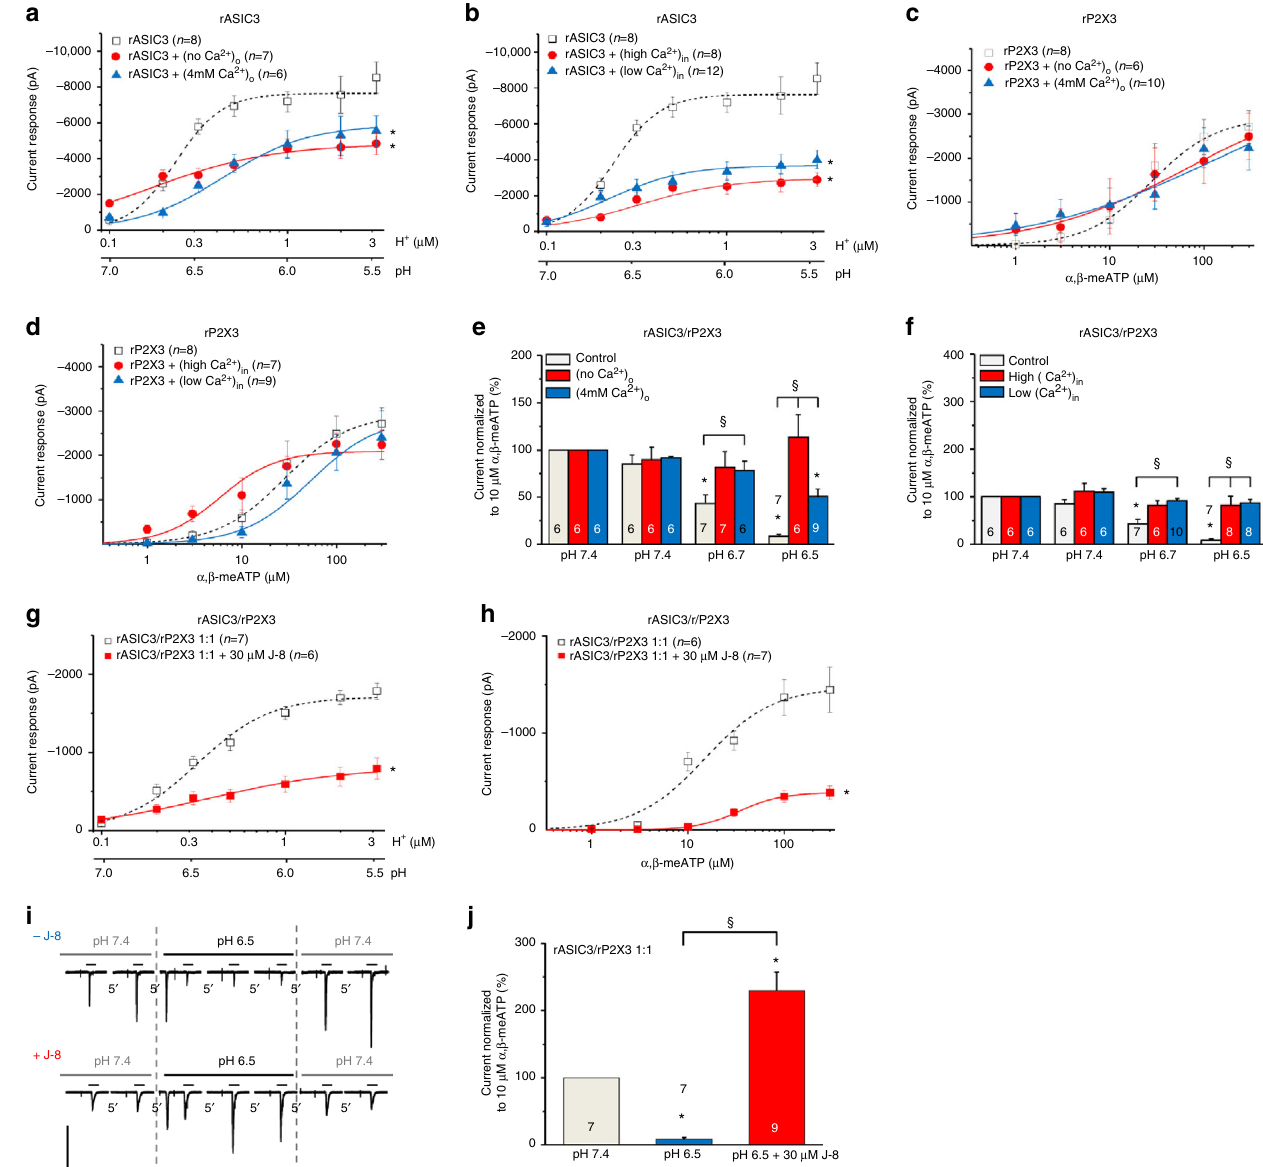
Fig. 4 Changes in the Ca 2 + concentration modify rASIC3 and rP2X3R currents in CHO cells. Whole-cell patch-clamp recordings at a holding potential of − 65 mV. a , b Concentration – response curves for protons in CHO cells transfected with rASIC3. a Inhibitory effect of an increase or decrease of the Ca 2 + concentration in the external medium ([Ca 2 + ] o ). b Inhibitory effect of an increase or decrease of the free Ca 2 + concentration in the patch pipette solution ([Ca 2 + ] i ). c , d Concentration-response curves for α , β -meATP in CHO cells transfected with rP2X3. c No effect of changes in [Ca 2 + ] o . d No effect of changes in [Ca 2 + ] i . Means ± S.E.M. of the indicated number of experiments. * P < 0.05; statistically signi fi cant difference of the I mean values at the highest agonist concentration (one-way ANOVA followed by the Holm – Sidak test). e , f CHO cells transfected with both rASIC3 and rP2X3 in a 1:1 ratio. Modulation of the unilateral interaction between rASIC3 and rP2X3Rs, by changes in [Ca 2 + ] o ( e ) and [Ca 2 + ] i ( f ); the experimental protocol is identical to that shown in Fig. 2a. * P < 0.05; statistically signi fi cant difference from the current amplitudes measured in normal extra- and intracellular Ca 2 + . § P < 0.05; statistically signi fi cant difference between currents at pH 6.7 or 6.5 at different Ca 2 + concentrations (one-way ANOVA followed by the Bonferroni test). Concentration – response relationships for protons ( g ) and α , β -meATP ( h ) in CHO-rASIC3/rP2X3R cells, in the absence and presence of J-8 (30 µ M). Means ± S.E.M. of the indicated number of experiments. * P < 0.05; statistically signi fi cant difference between the I mean values at the highest agonist concentration (Student ’ s t -test). i Potentiation of the α , β -meATP (30 µ M) current by co-application with a J-8 (30 µ M)-containing, low pH (6.5) external medium, but inhibition in the absence of J-8 by acidi fi cation; representative tracings. j Percentage changes of α , β -meATP-induced current responses were calculated with respect to the second current amplitude before the pH shift. Means ± S.E.M. of the indicated number of experiments. * P < 0.05; statistically signi fi cant difference between the current amplitudes before and after the pH shift from 7.4 to 6.5 in the presence of J-8. § P < 0.05; statistically signi fi cant difference between current amplitudes at pH 6.5 in the presence or absence of J-8 (Mann – Whitney test). The scale labels for the vertical and horizontal bars in ( i ) were 1 nA and 50 s,